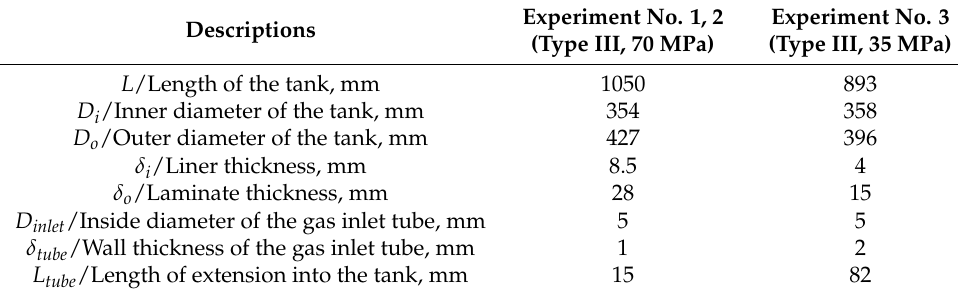
Table 1. Dimensions of the geometric model [13,27].